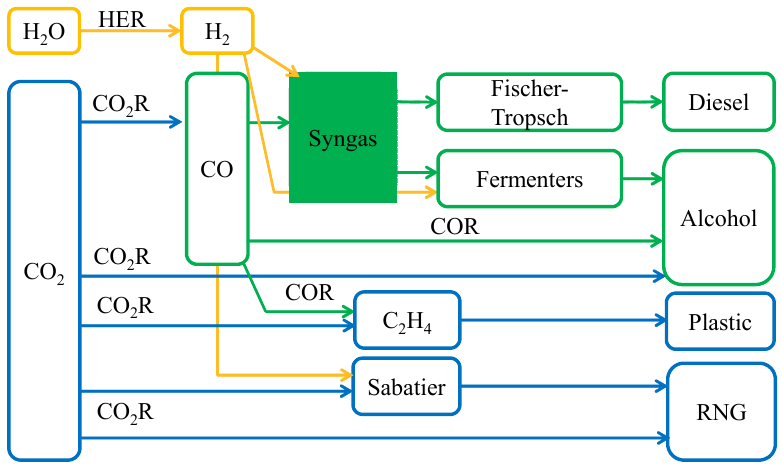
Figure 1. Possible renewable-energy-powered routes to create commodity chemicals driven by electrocatalysis from H 2 O (yellow) and CO 2 (green, blue) as feedstocks [8]. Reprinted with permission from Ref. [8]. Copyright © 2023, The American Association for the Advancement of Science.